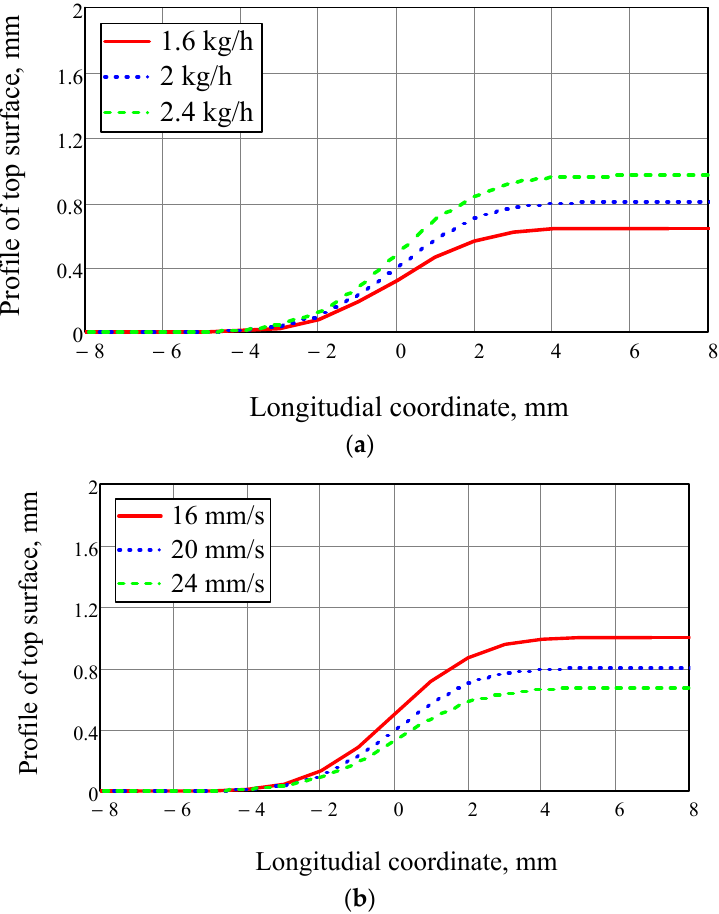
Figure 2. Melt pool top surface profile for 316 L steel for different powder feed rates ( a ) and motion speeds ( b ); laser beam radius on the surface was 2.5 mm, beam power was 2000 W, and powder jet diameter was 3 mm. А comparison of the melt pool surface profiles for different materials is shown in Figure 3. It can be seen from the figure that with the same mode parameters, the VT6 alloy gives a greater increment in height when the bead is deposited. At the same time, the process efficiency for steel and nickel alloy is approximately the same.